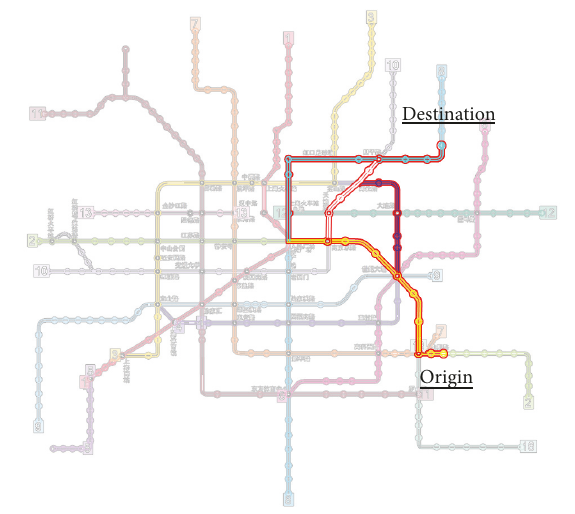
Figure 7: Shanghai metro